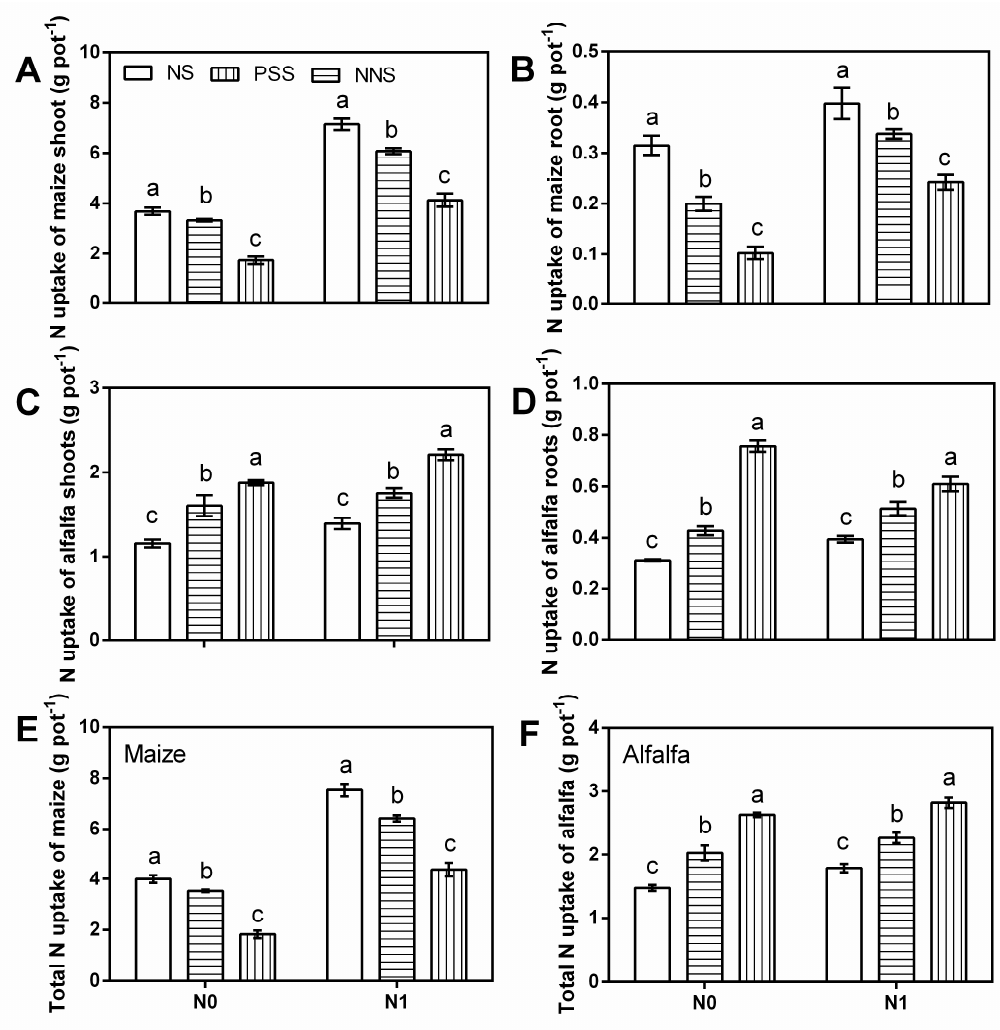
Figure 3. Effects of root separation and N addition on maize ( A , B ), alfalfa ( C , D ), and total N uptake ( E , F ) in 2015 and 2016. Bars are means ± SD. Different lowercase letters indicate significant differences in maize and alfalfa N uptake among different root separation treatments at the same nitrogen level at the p ﹤ 0.05 probability level. Other symbols are the same as in Figure 2.